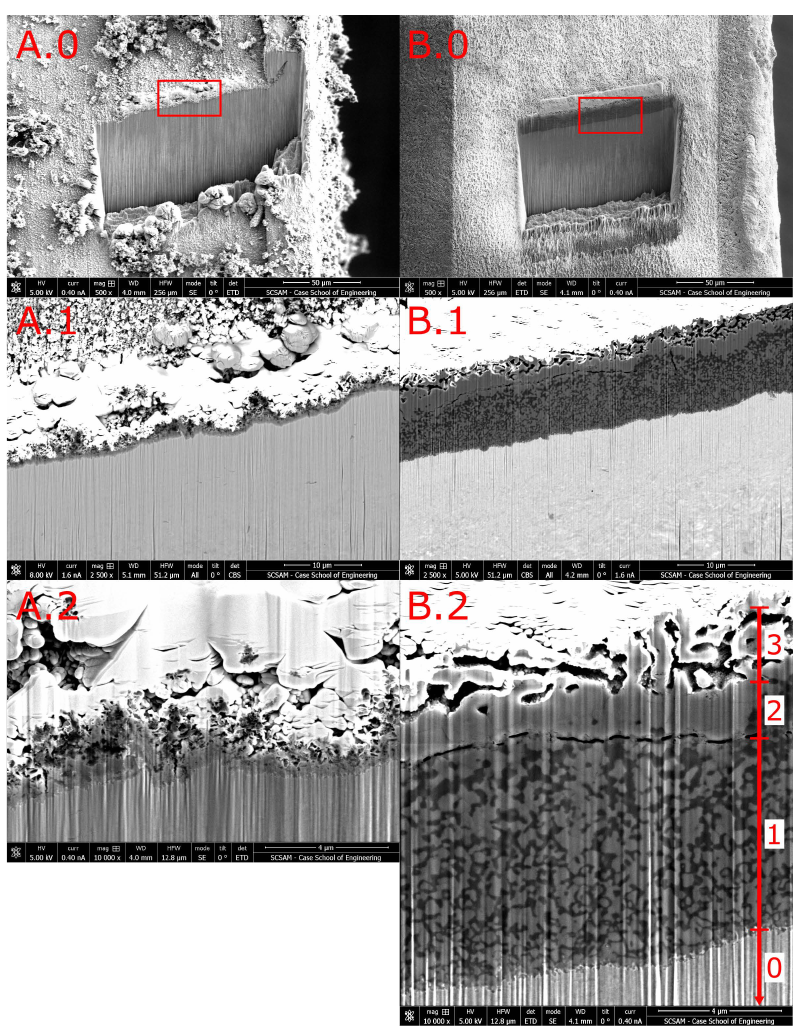
Figure 4. SE ( A.0 , B.0 , A.2 , B.2 ) and BSE ( A.1 , B.1 ) SEM images of FIB-cuts showing the activated sur- face of an AISI-316L sample. ( A.0 ) through ( A.2 ) depict sample SX . ( B.0 ) through ( B.2 ) depict sample TX . The red outlines in ( A.0 ) and ( B.0 ) mark the view areas shown in ( A.1 ) and ( B.1 ), respectively. SX : activated by direct HCl gas exposure with the “double-HCl” process. TX : activated by gas from pyrolysis of 15 N 2 H 4